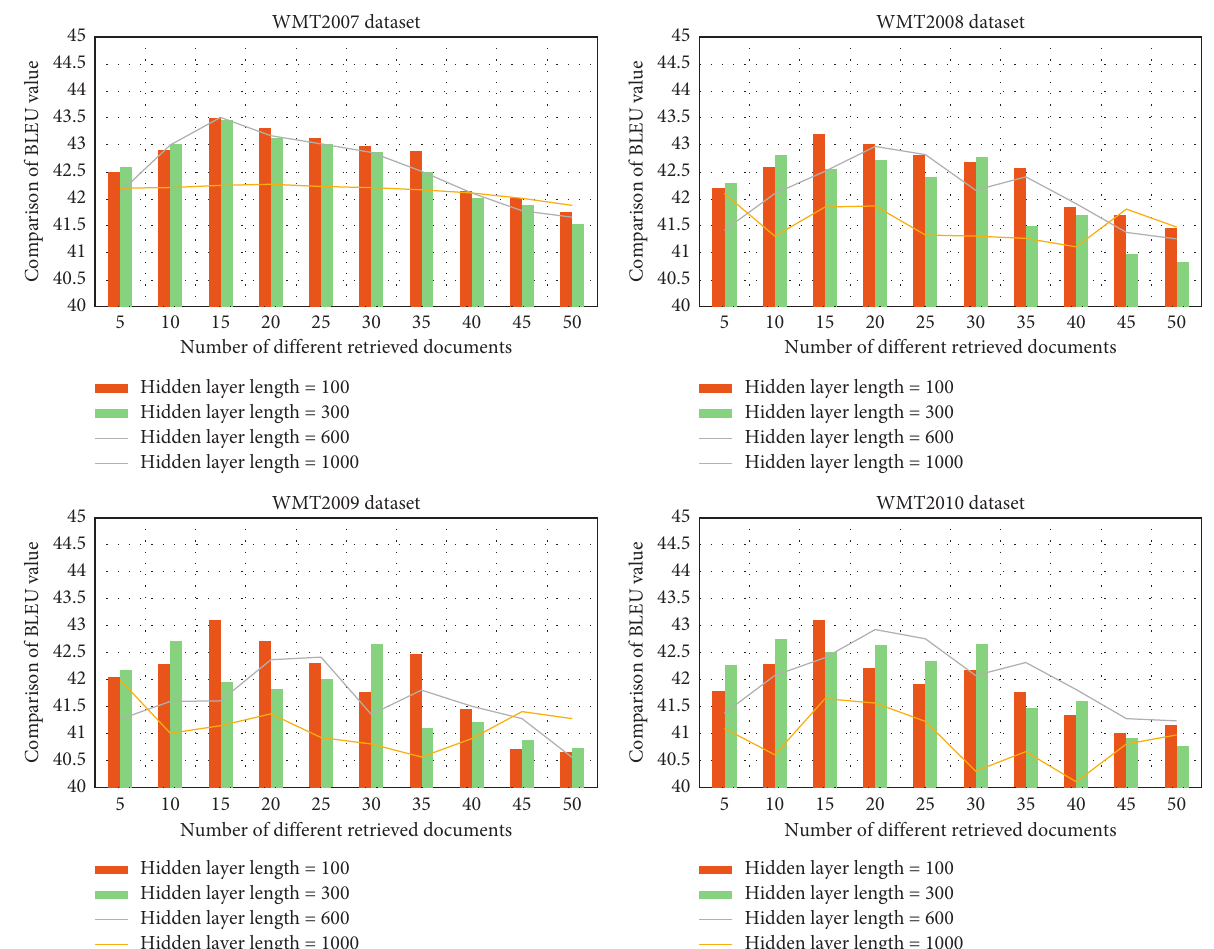
Figure 7: The impact of the number of retrieved documents and the length of the hidden layer on the accuracy of machine